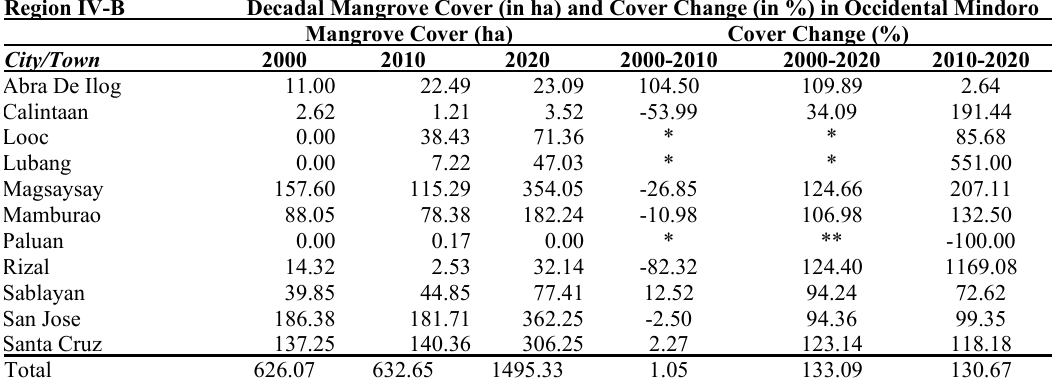
Table 3. Extracted Mangrove area (in ha) estimates in Occidental Mindoro. Note: *percent change from 0 to a value. **percent change from 0 to 0.